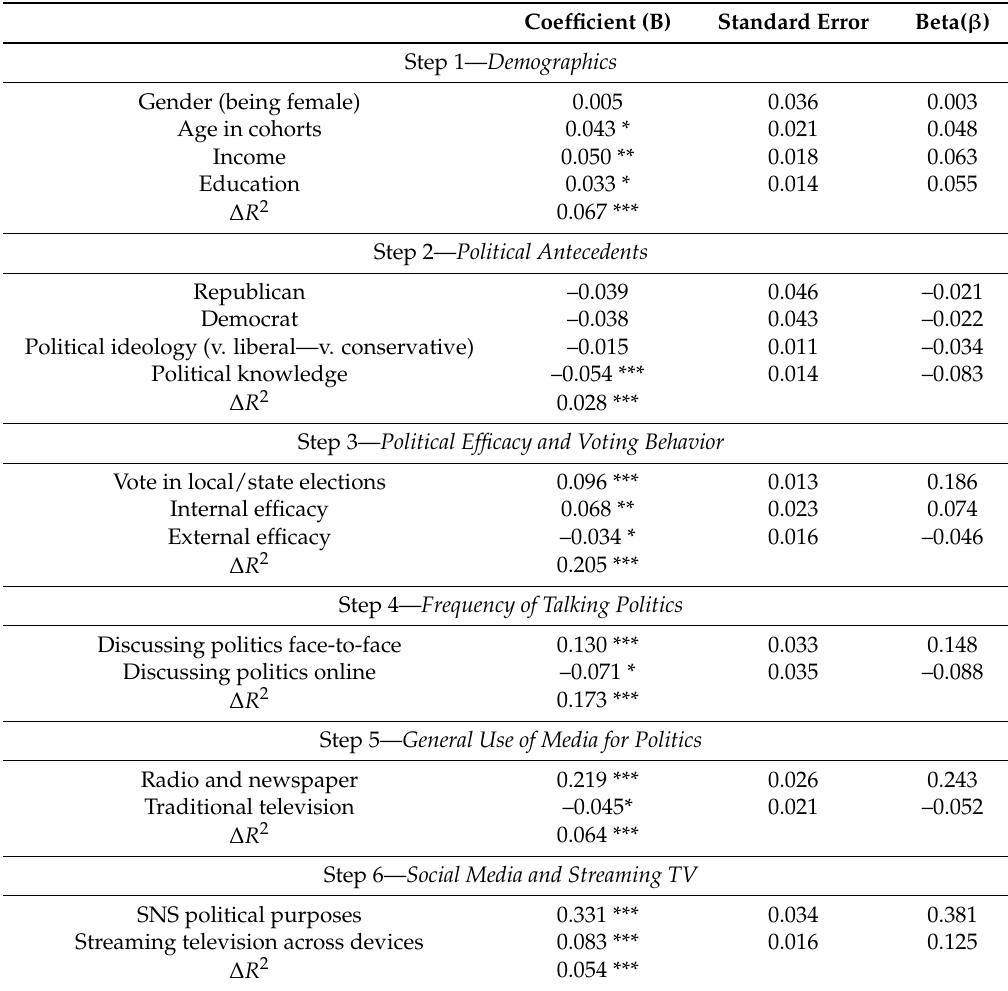
Table 3. Regression Model of Offline Political